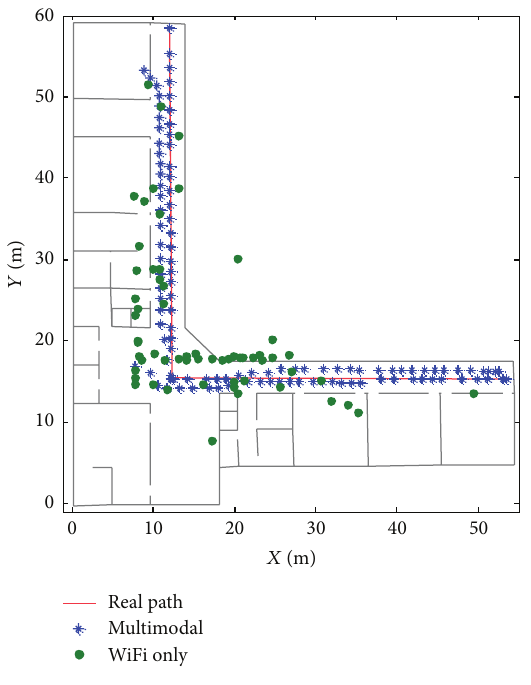
Figure 7: Localization